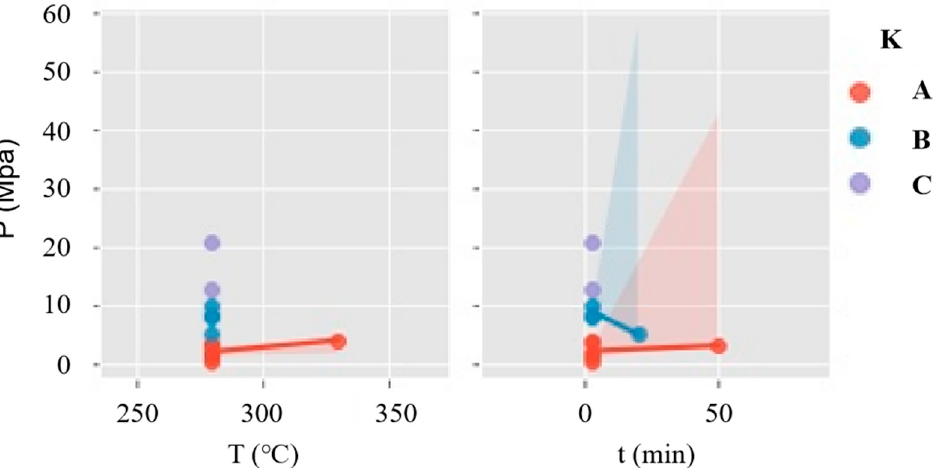
Figure 5. Schematic diagram of the relationship between bonding time, bonding temperature, and bonding strength in three categories (A, B, and C).